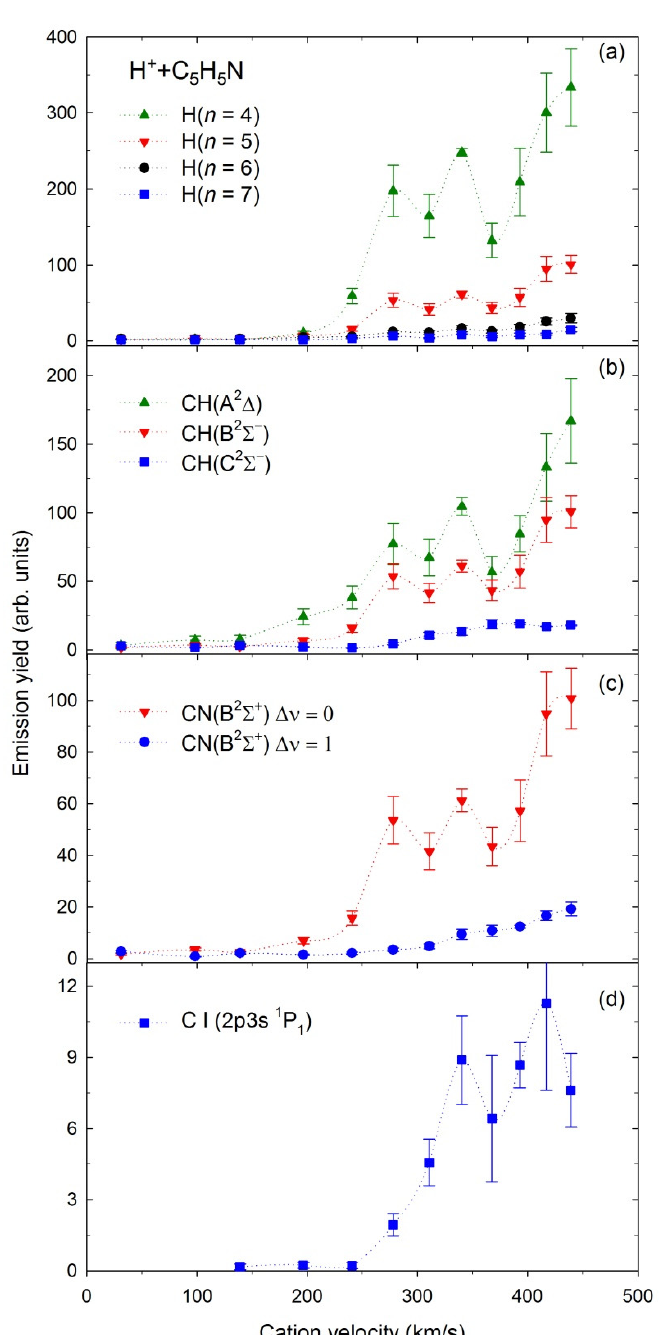
Figure 7. Emission yields of the excited fragments obtained in collisions of H + with pyridine.